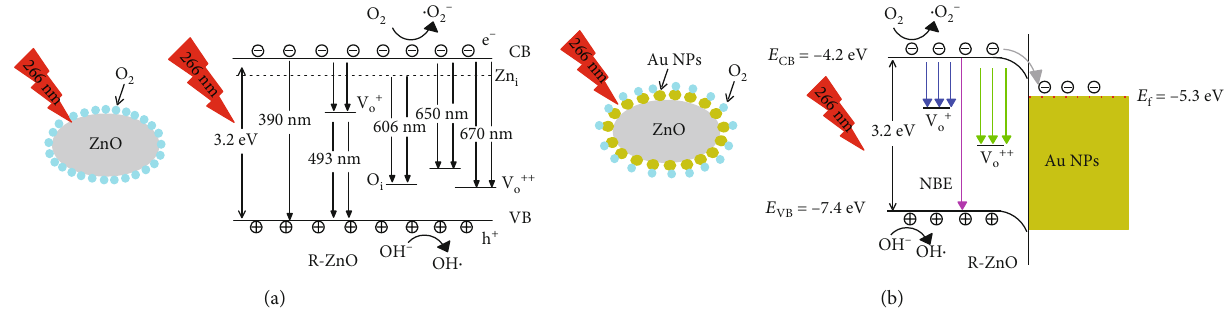
Figure 13: Schematic illustrations of photogenerated carrier transfer and recombination transient process for pristine R-ZnO (a) and Au/R- ZnO nanosystem (b) in ambient condition under 266 nm irradiation,